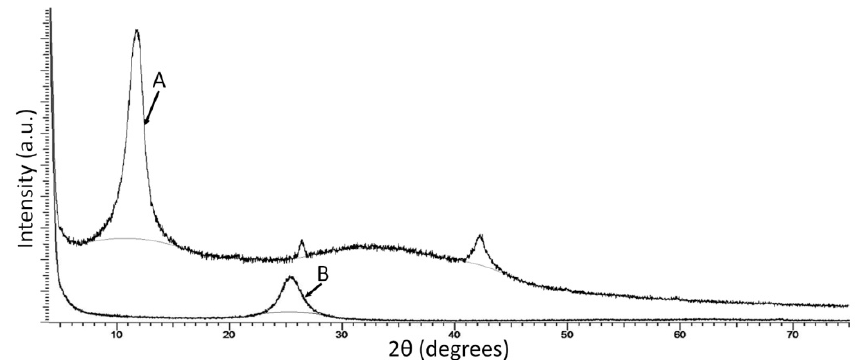
Figure 5. XRD spectra of (A) as prepared GO and (B) reduced